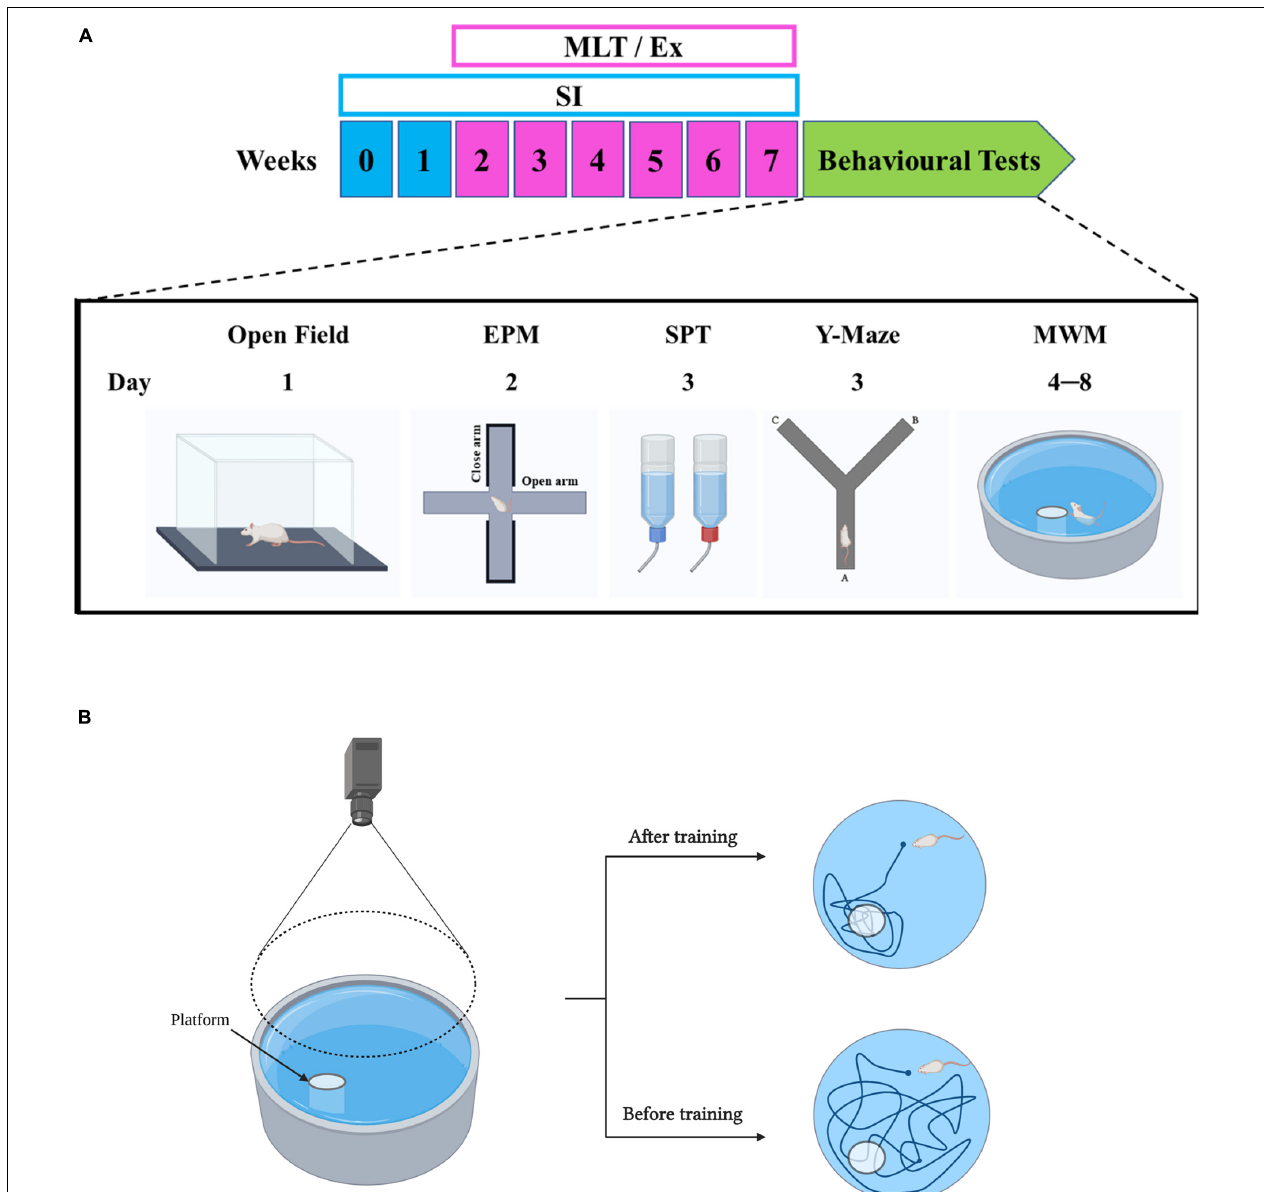
FIGURE 1 | (A) Timeline of the experiment and overview of the behavioral tests. (B) MWM test. MLT, melatonin; Ex, exercise; SI, social isolation; EPM, elevated plus maze; SPT, sucrose preference test; MWM, Morris water maze. Created by